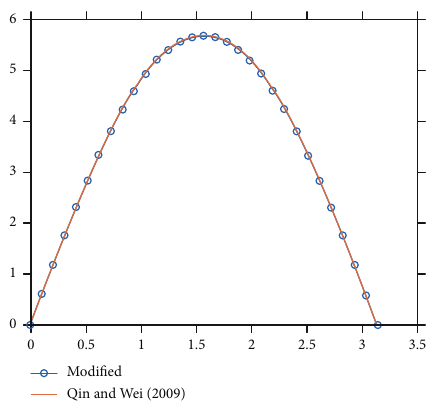
Figure 13: The variations of the system of equations (42) and the solution of the regularized system of equations (12) – (15) for p = 1 , k = 1 : 1 , α = 0 : 001 , and y = 0 : 6 .